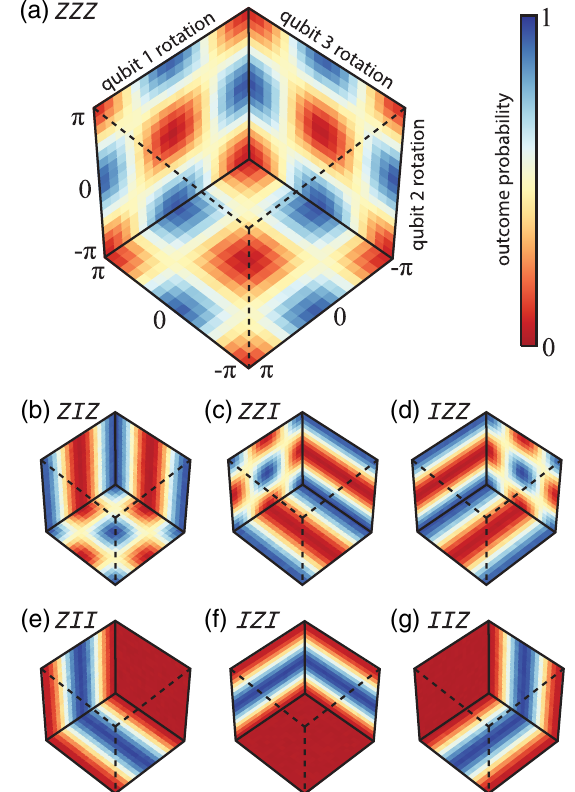
FIG. 3. Demonstration of parity measurement outcomes. For all seven nontrivial three-qubit subset-parity operators, we show ancilla excitation probabilities as a function of initial register state. In each panel, the three axes specify the initial state of each register qubit, parametrized by rotation angle about the X axis after initialization in the ground state. We depict three plane cuts through that parameter space. The color scale indicates the probability to find the ancilla in the excited state. Panel (a) shows measurement operator ZZZ. The second row (b) – (d) shows two- qubit parity measurements. It is easily seen that the outcome is independent of the preparation of one qubit. The third row (e) – (g) shows single-qubit measurements, reflecting sensitivity to only one preparation axis. We extract assignment fidelities from these data of 89% – 95% that improve to 94% – 97% with postselection on a success